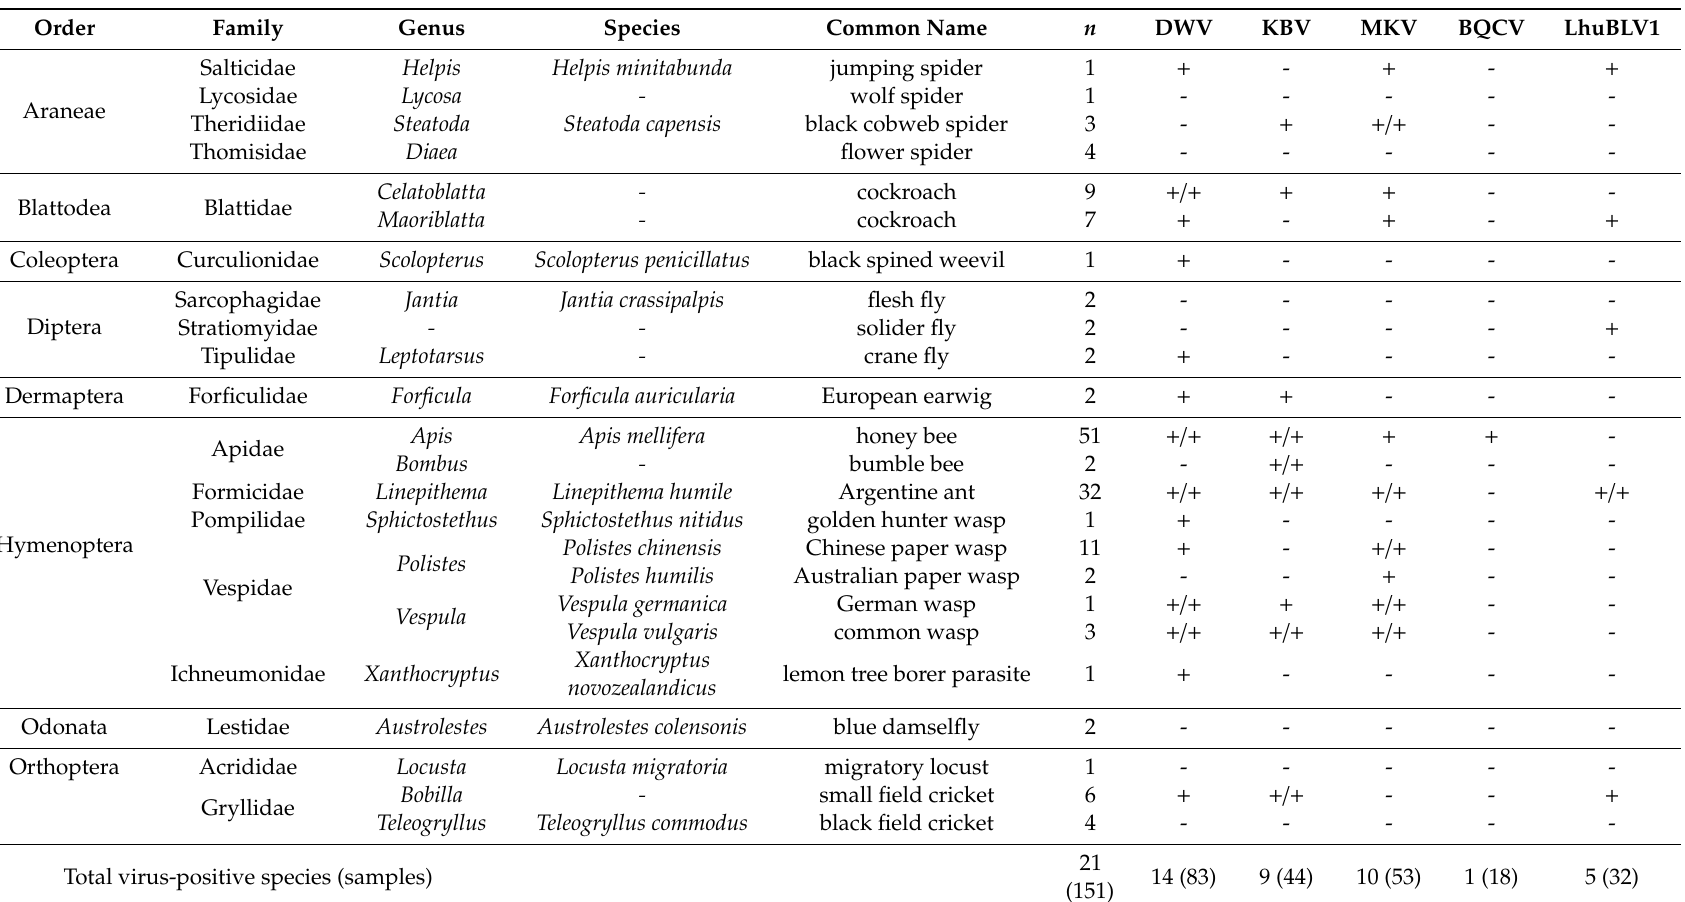
Table 1. Virus presence in pollinators and associated arthropods tested for deformed wing virus (DWV), Kashmir bee virus (KBV), Moku virus (MKV), black queen cell virus (BQCV), and Linepithema humile bunya-like virus 1 (LhuBLV1) using RT PCR. Virus not found in species: -; virus found in species: + ; active viral replication confirmed: +/+ . Summary in bottom